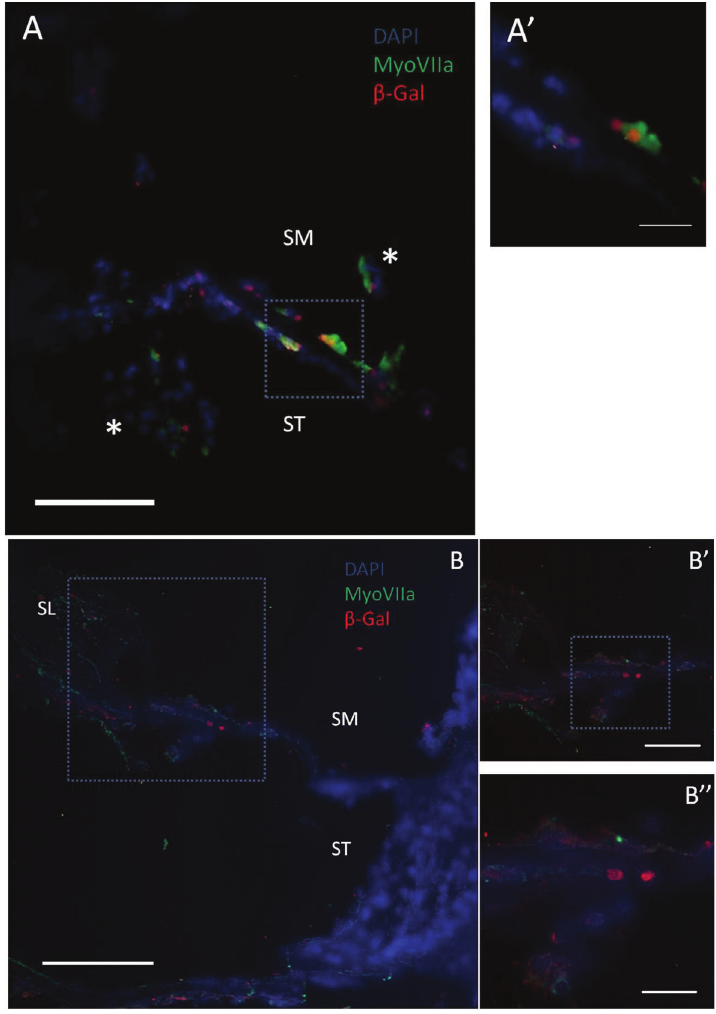
Figure 3 . Some mIESCs integrated into the neomycin-injured cochlea and expressed a hair cell marker. Transplanted mIESCs were detected in the neomycin-injured cochleas of guinea pigs as shown by indirect immuno fl uorescence of b -galactosidase ( b -gal) (red) to detect the protein expressed by the bacterial LacZ reporter gene. Myosin VIIa (hair cell marker) was detected by a speci fi c antibody (green). Nuclear DNA was stained with DAPI (blue). Some transplanted mIESCs ( b -gal + ) were positive for myosin VIIa. Most transplanted mIESCs were found in clus- ters (asterisks in A ) in the endolymphatic space, and a small number of these cells were inte- grated into the basilar membrane ( A 0 and B 00 ). A and B are images of cochleas from two animals. Higher magni fi cation views of the regions de fi ned by the square in A and B are shown in A 0 and B 0 -B 00 , respectively. ST: scala tympani; SM: